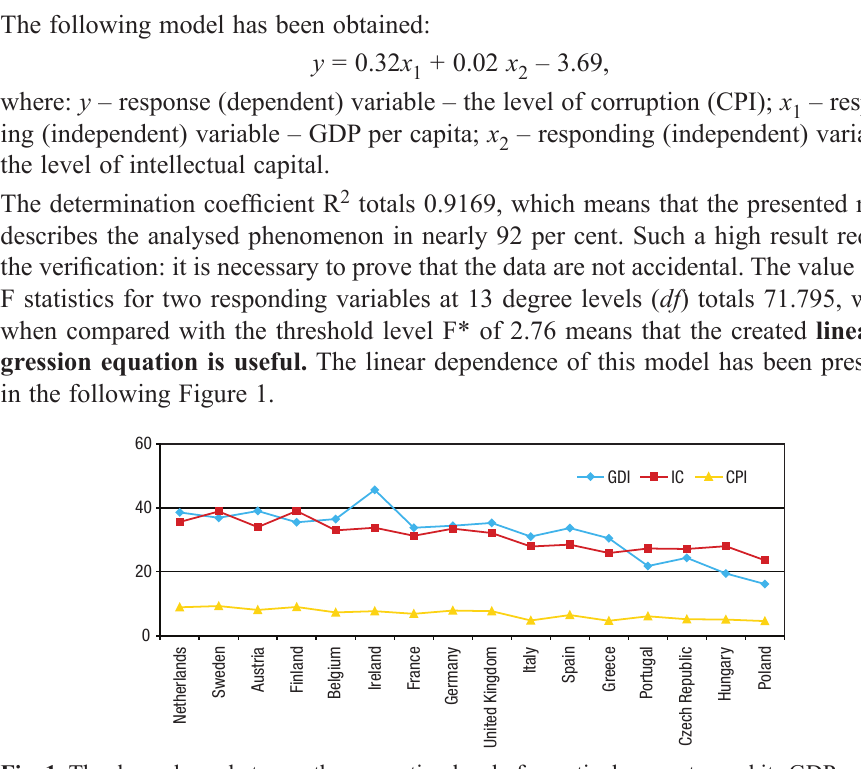
Fig. 1. The dependence between the corruption level of a particular country and its GDP and NIC Source : authors’ own